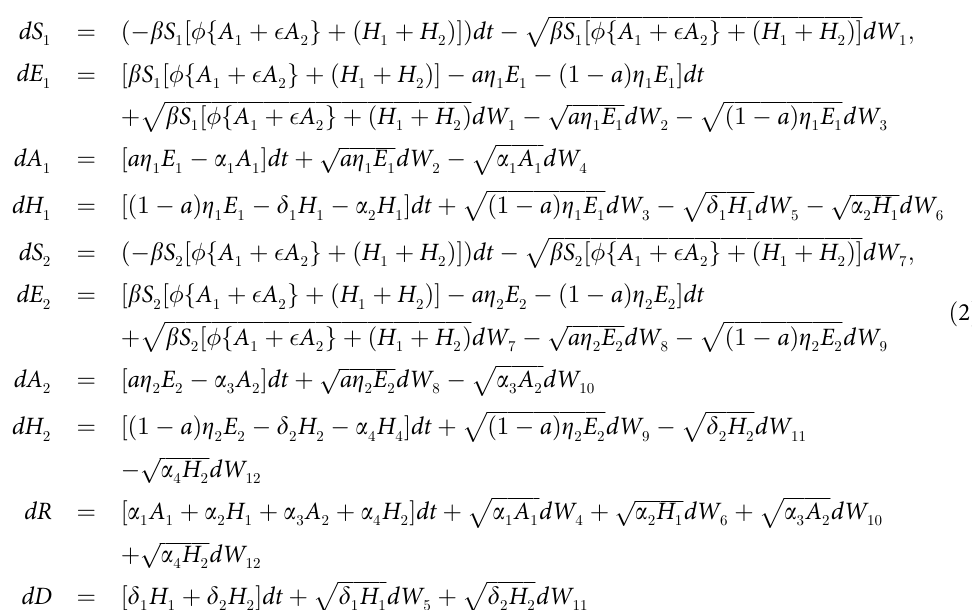
p ffiffiffiffiffiffiffiffiffiffiffi a Z E 1 1